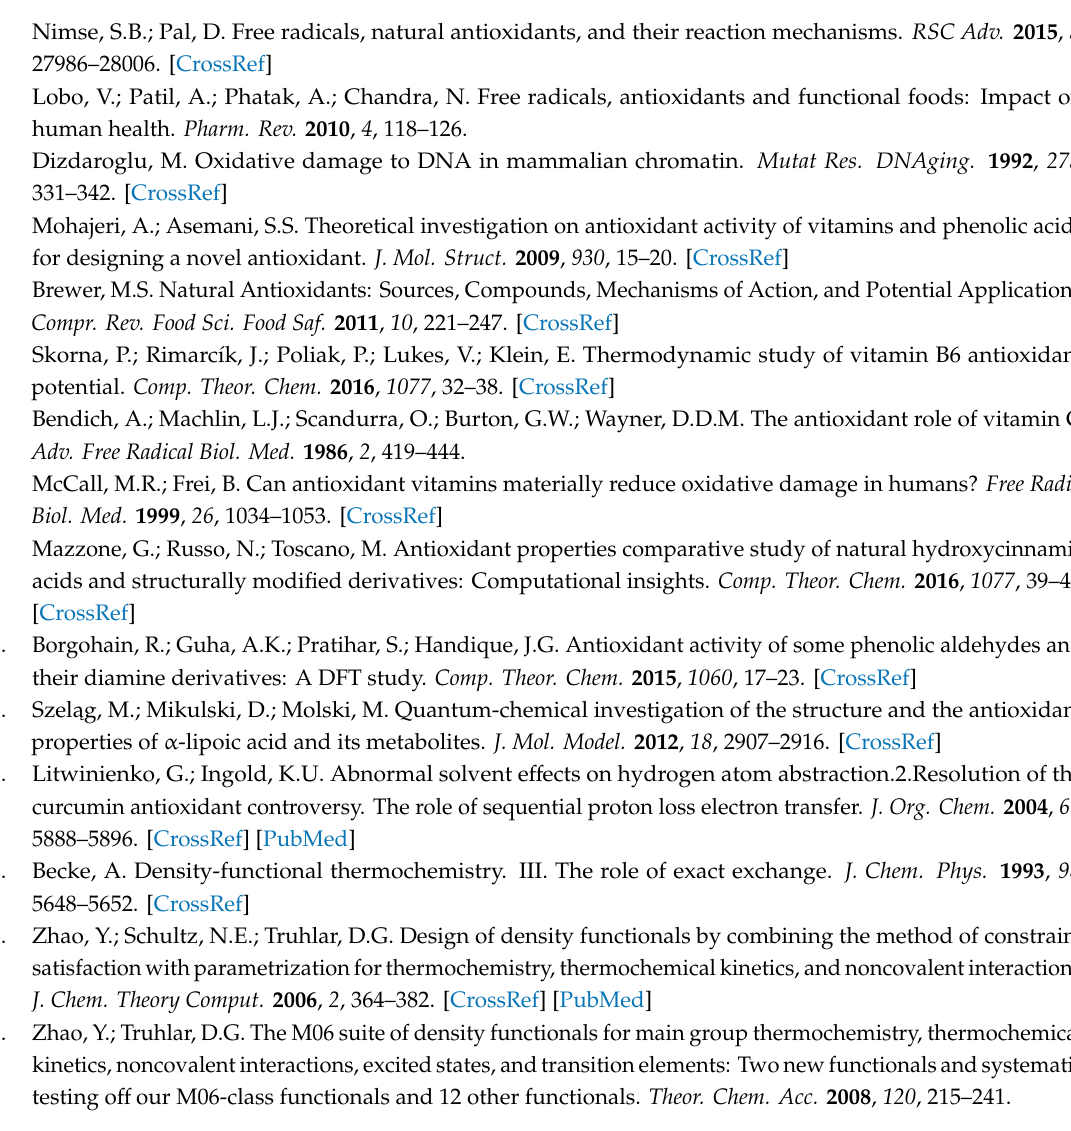
Table S1: Reaction enthalpies in kJ mol − 1 for the selected dietary vitamins, employing functional of B3LYP, M05-2X and M06-2X in aqueous medium